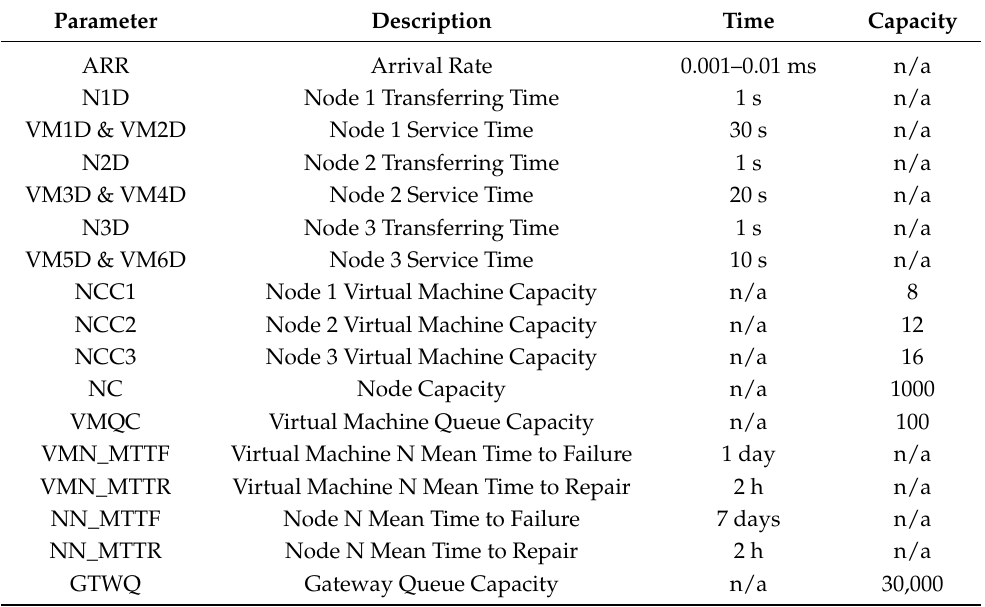
Table 6. Default parameters of the SRN system